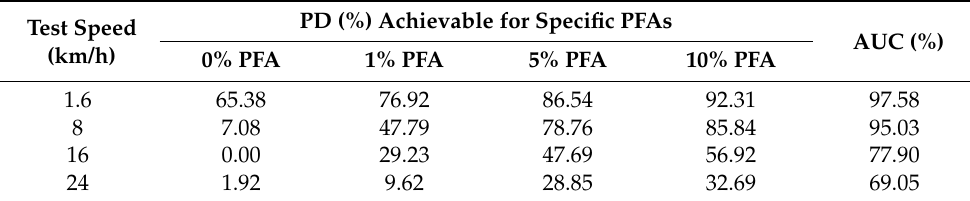
Table 2. Significant PD and PFA values extracted from the cumulative ROC curves of Figure 23 [47].